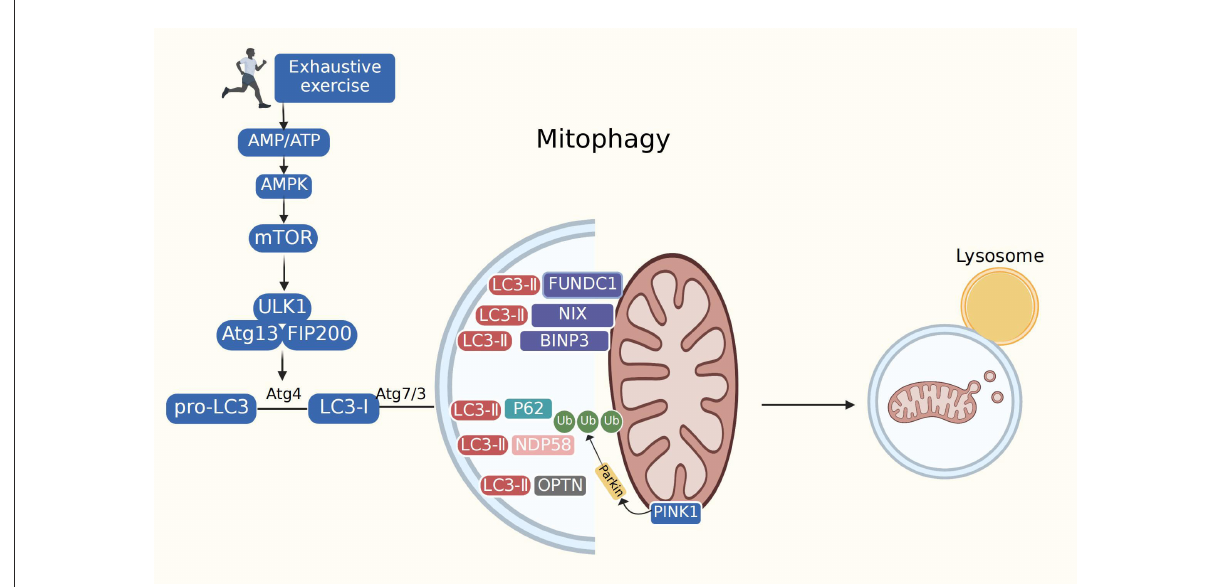
FIGURE3 Mitophagy. Mitophagy is mediated by many of cellular signal mechanisms including PINK1, Parkin, mitophagy receptors (BNIP3L/NIX, FUNDC1), as well as certain mitophagy adaptors. Adapter proteins (p62, OPTN, NDP58) recognize phosphorylated polyubiquitin chains on mitochondrial proteins and initiate autophagosome formation by binding to LC3. The exact role of mitophagy in exhaustive exercise remains controversial. Most studies have depicted suppressed autophagy during exhaustive exercise. However, several research have found excessive autophagy in exhaustive exercise. Mitophagy impairment may lead to the accumulation of dysfunctional mitochondria, prompting oxidative stress, mitochondrial dysfunction and cardiac